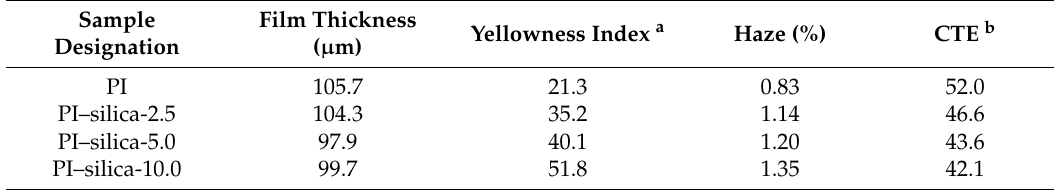
Table 2. Film thicknesses, yellowness indices, haze values, and CTE values of the PI and PI–silica composite